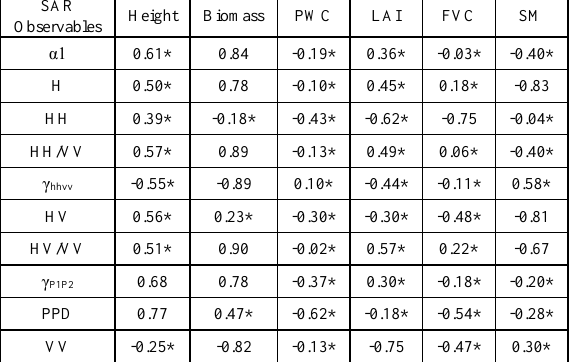
Table 3. Correlation (R Pearson) between SAR observables and field estimations for L7 (wheat). Non-significant correlations at 95% confidence level are indicated by *.